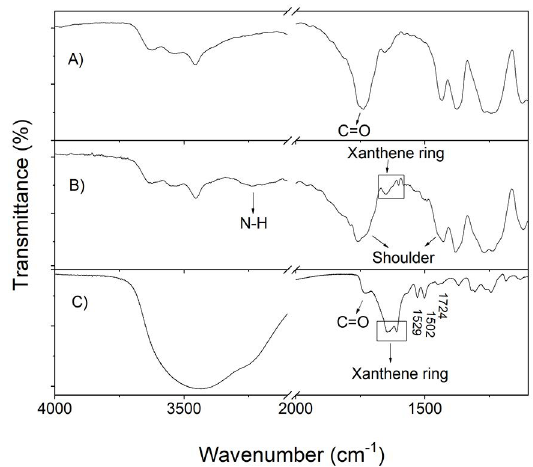
Figure 7. FTIR spectrum of PVA/PVAc-Rhodamine (red) and PVA/ PVAc microspheres (black).